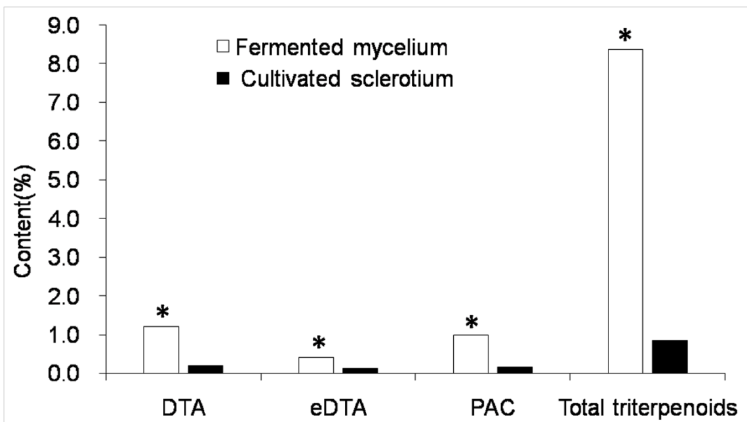
Figure 2. Contents of the three main triterpenoids and total triterpenoids in mycelia and sclerotium of P. cocos. Asterisks indicated the significance ( p < 0.01) compared with cultivated sclerotium. Molecules 2020 , 25 , x FOR PEER REVIEW 5 of 13